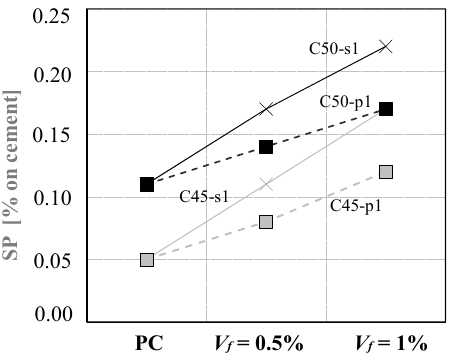
Figure 6. Superplasticizer (SP) dosage necessary for FRC ( V f = 0.5% and V f = 1%) to obtain the same slump as PC (180 ± 20 mm).